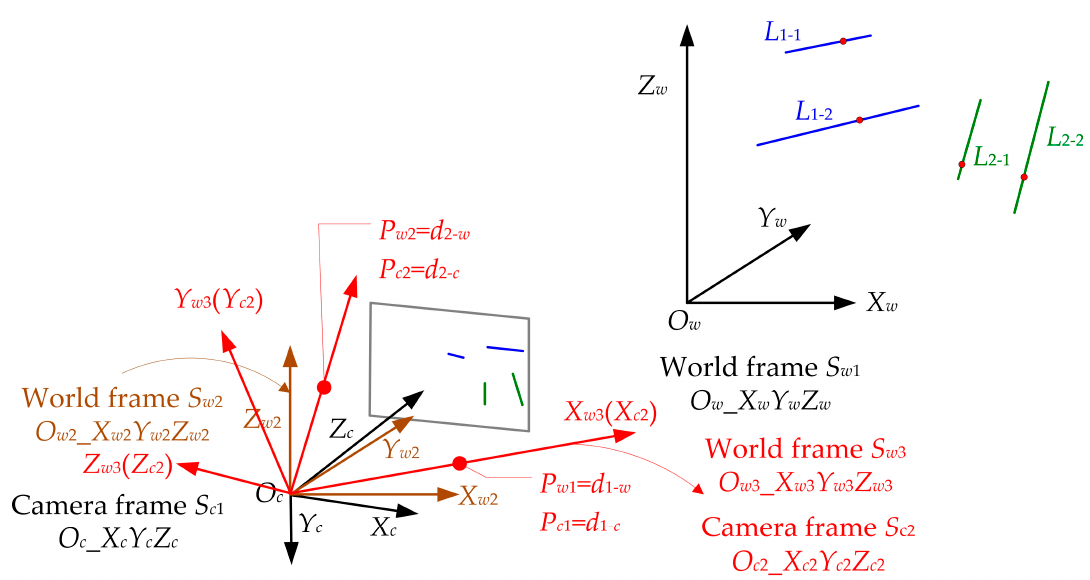
Figure 4. New camera frame S c 2 and new world frame S w 3 are plo tt ed in red.